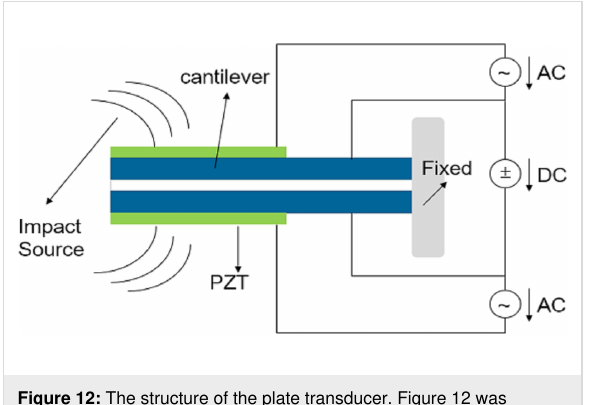
Figure 12: The structure of the plate transducer. Figure 12 was redrawn from [98]. Pyroelectric power generation: Pyroelectric crystals can generate electricity with a change in temperature owing to the net change in polarization of the crystal units [100]. Therefore, it can be an ideal high-voltage source for MEMS/NEMS devices. Similar to the triboelectric effect, the pyroelectric effect can also be used as an energy source for microscale energy systems with NEM switches for corresponding sensors and actuators.